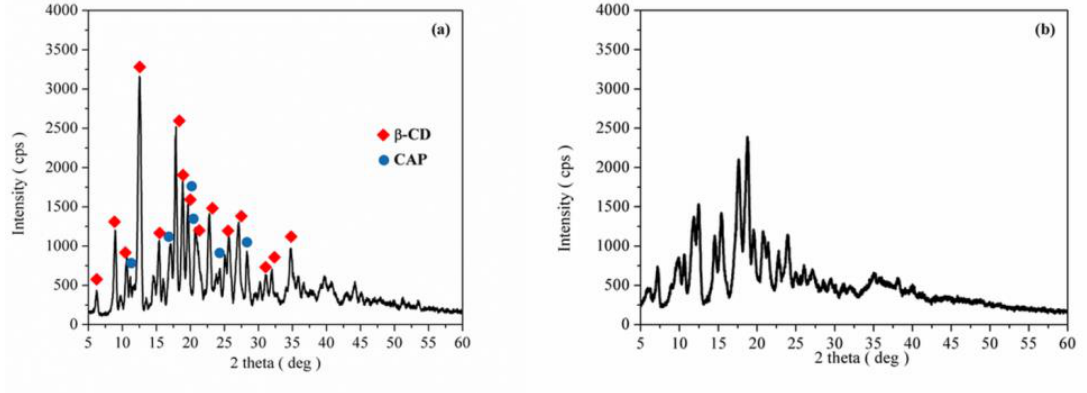
Figure 5. XRD pattern of ( a ) the CAP- β -CD physical mixture and ( b ) the CAP- β -CD inclusion